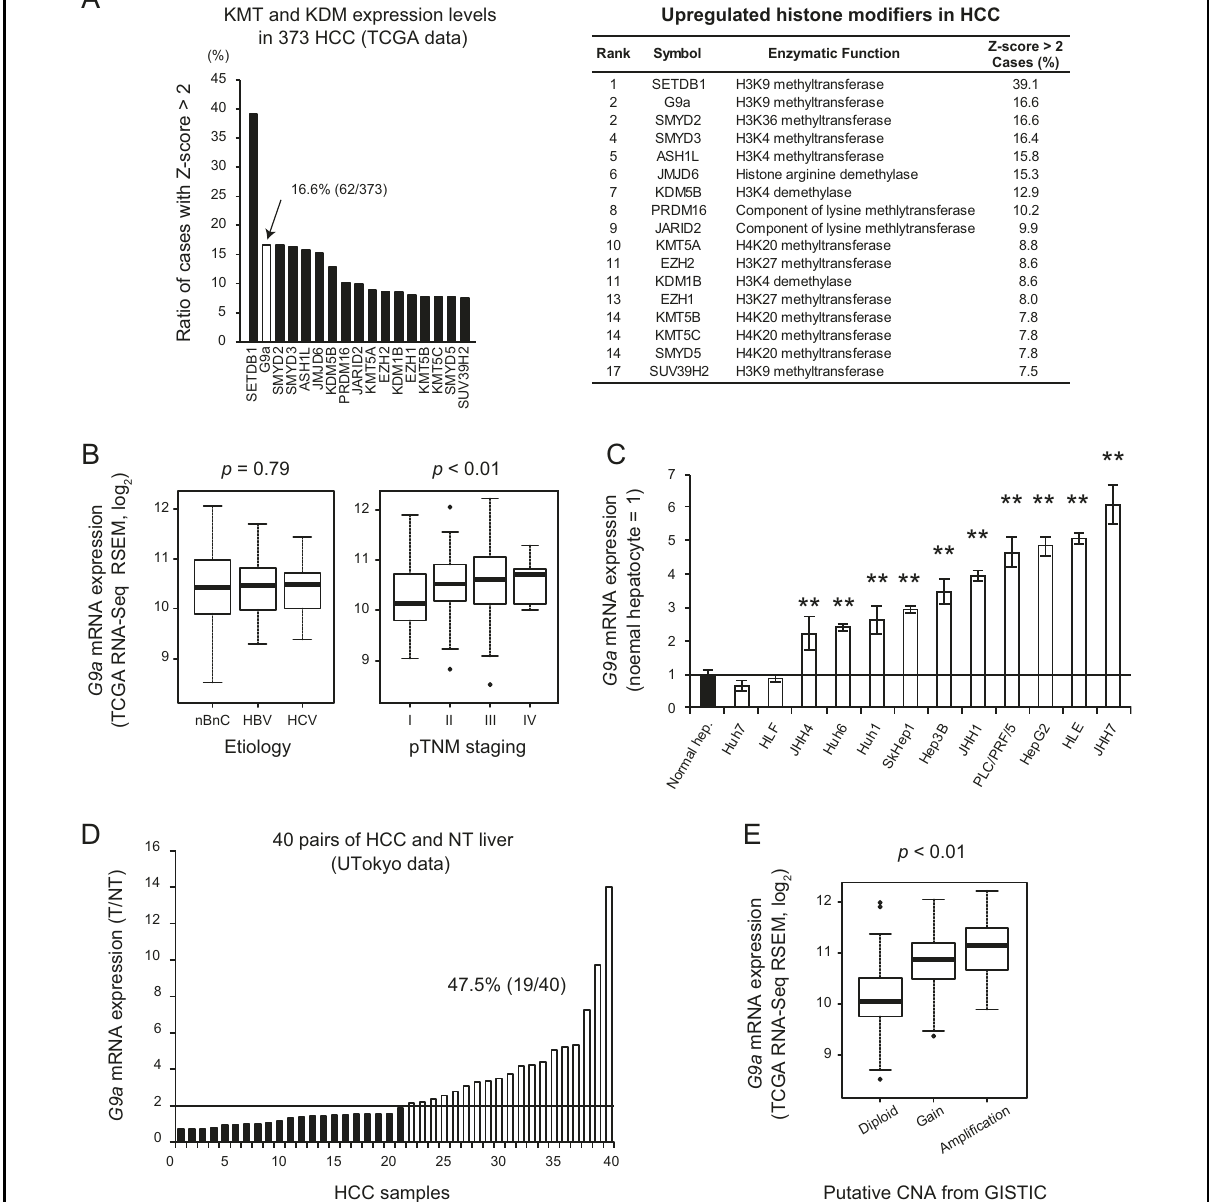
Fig. 1 G9a is highly expressed in human HCC. A Relative expression levels of histone-lysine methyltransferase (KMT) and demethylase (KDM) in hepatocellular carcinoma using The Cancer Genome Atlas (TCGA) data set. B G9a expression is comparable among etiologies (nBnC, n = 180; HBV, n = 97; HCV, n = 49; p = 0.79, one-way ANOVA) and increases according to the pTNM stage in the TCGA cohort (Stage I, n = 171; II, n = 85; III, n = 85; IV, n = 5; p < 0.01, one-way ANOVA). The top and bottom boxes represent the fi rst and third quartiles, respectively. The thick line inside each box represents the median. Whiskers represent 1.5 interquartile ranges from the hinges. Open circles represent outliers. C G9a is upregulated in many HCC cell lines. Data are mean ± SEM from three independent experiments. ** p < 0.01, Student ’ s t test. D G9a expression levels in 40 pairs of HCC (T) and surrounding non-tumorous (NT) liver obtained in our institution. G9a expression level is more than double in the tumor in 19 of 40 cases (47.5%). E G9a gene copy number is positively correlated with mRNA expression levels in the TCGA data set ( p < 0.01, one-way